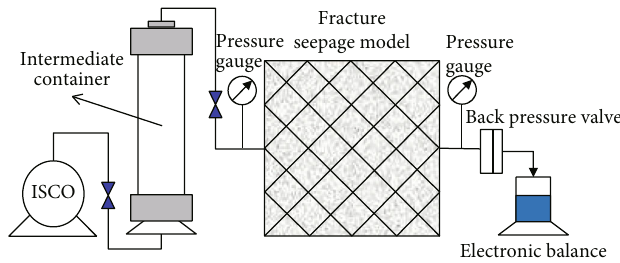
Figure 5: Schematic of the measurement setup.